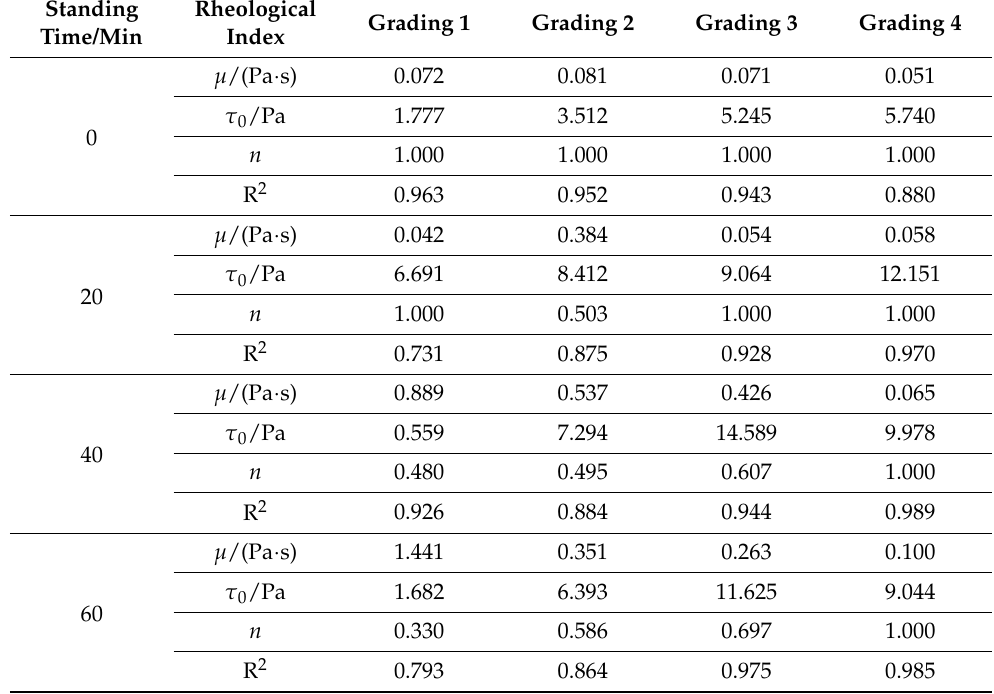
Table 3. Rheological parameters of filling paste at 60% mass